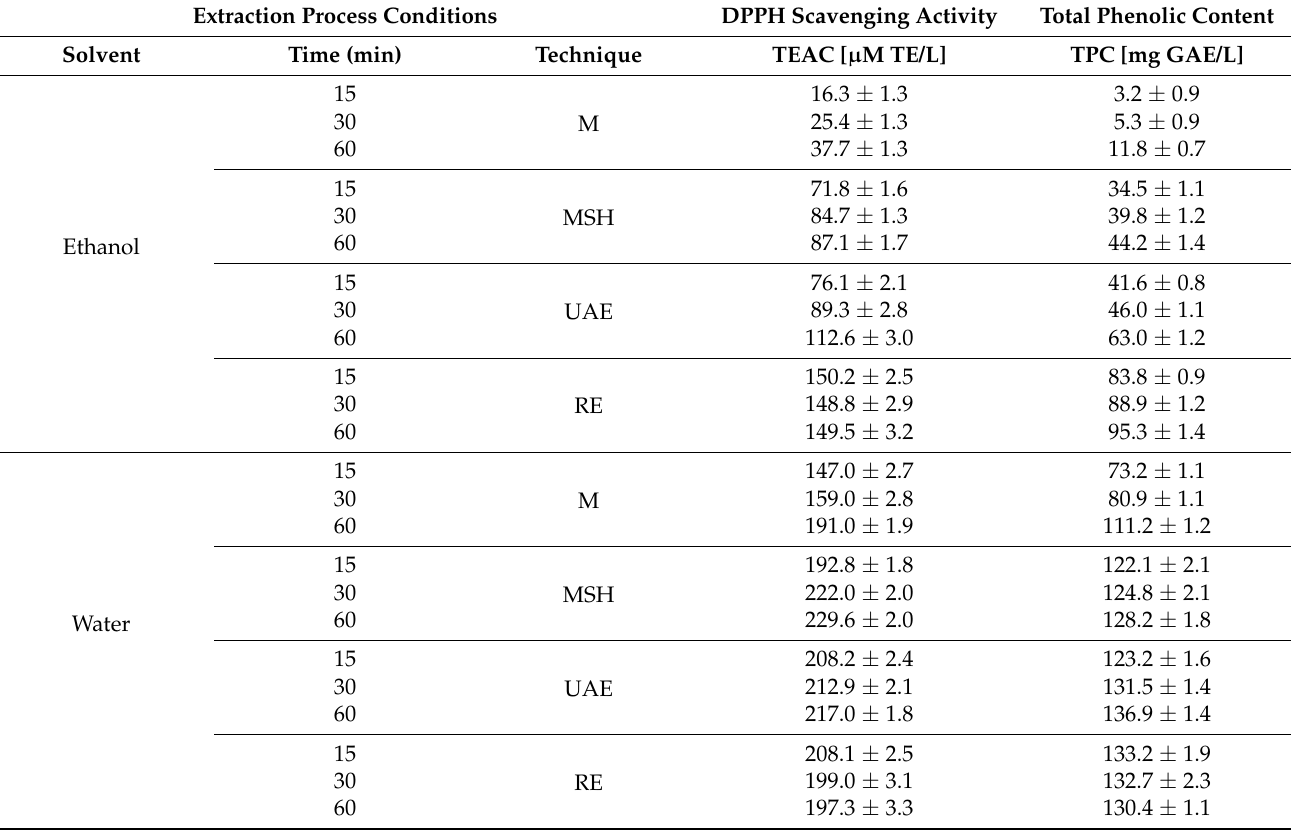
Table 1. DPPH radical scavenging activity and total phenolic contents of maca ( L. meyenii ) root extracts obtained using ethanol or water as the solvent in various extraction